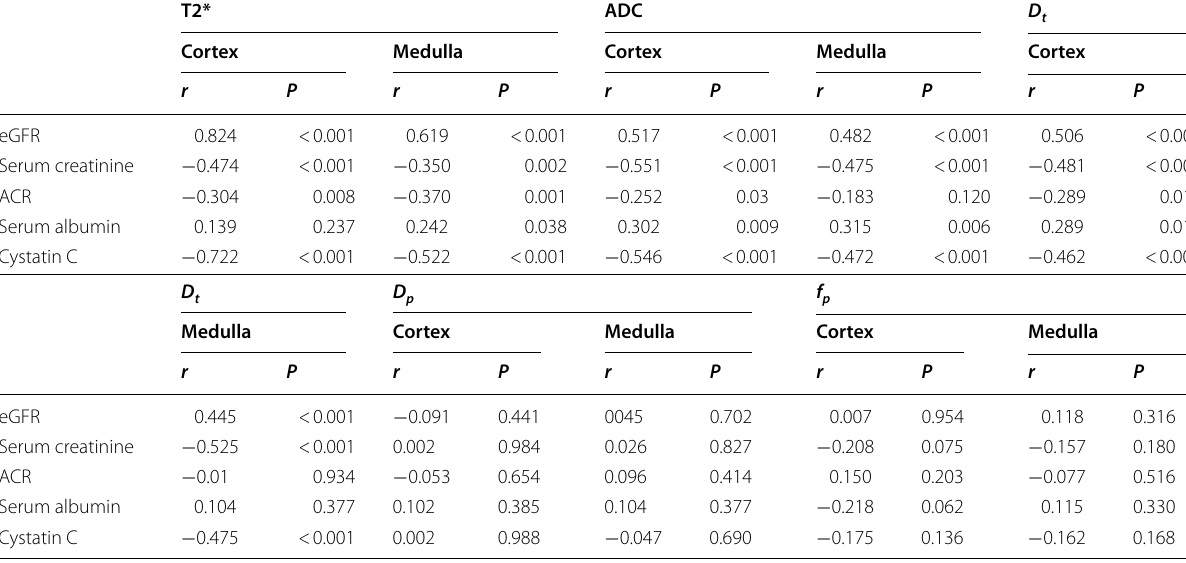
Table 5 Correlation of clinical data and MRI- derived parameters